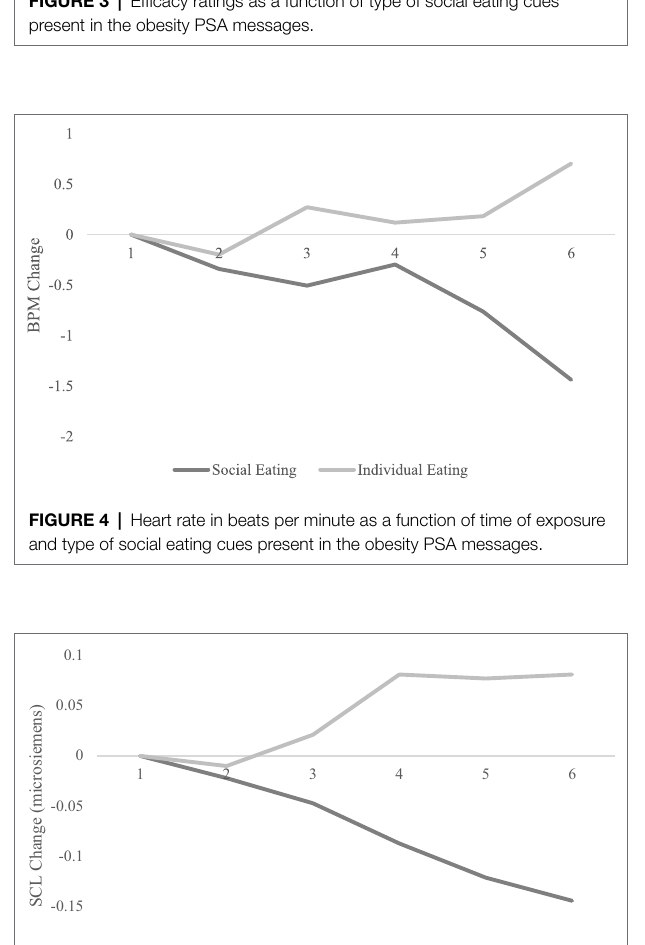
eating behaviors ( M = 2.62, SE = 0.10) compared to when individual eating cues were present ( M = 3.29, SE = 0.12). Hypothesis 4 was supported.